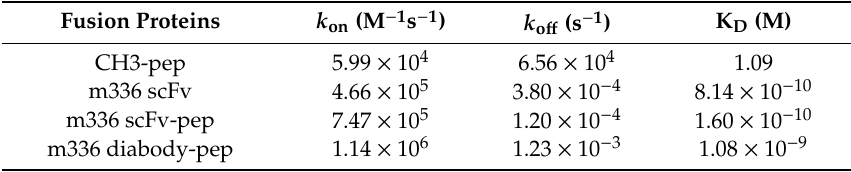
Figure 2. Interactions between m336 scFv ( A ), m336 scFv-pep ( B ), and m336 diabody-pep ( C ) with MERS-CoV S protein measured using the ProteOn XRP36 SPR system. Table 1. Binding kinetics analysis of fusion proteins to MERS-CoV S protein.